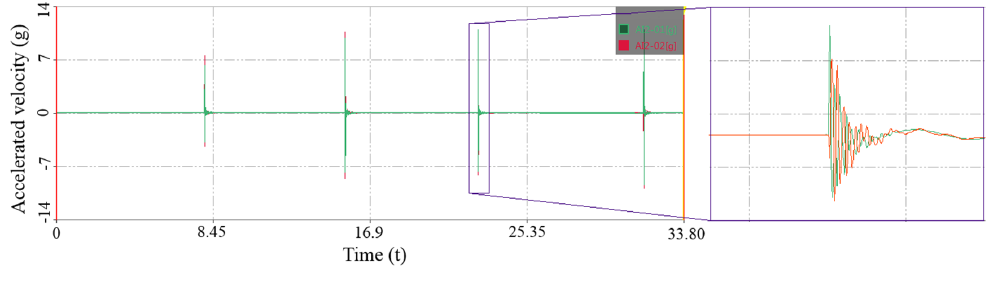
Figure 5. Natural frequency response test: ( a ) sketch for supports and sensors locations (unit: mm); ( b ) experimental setup for the natural frequency response test.